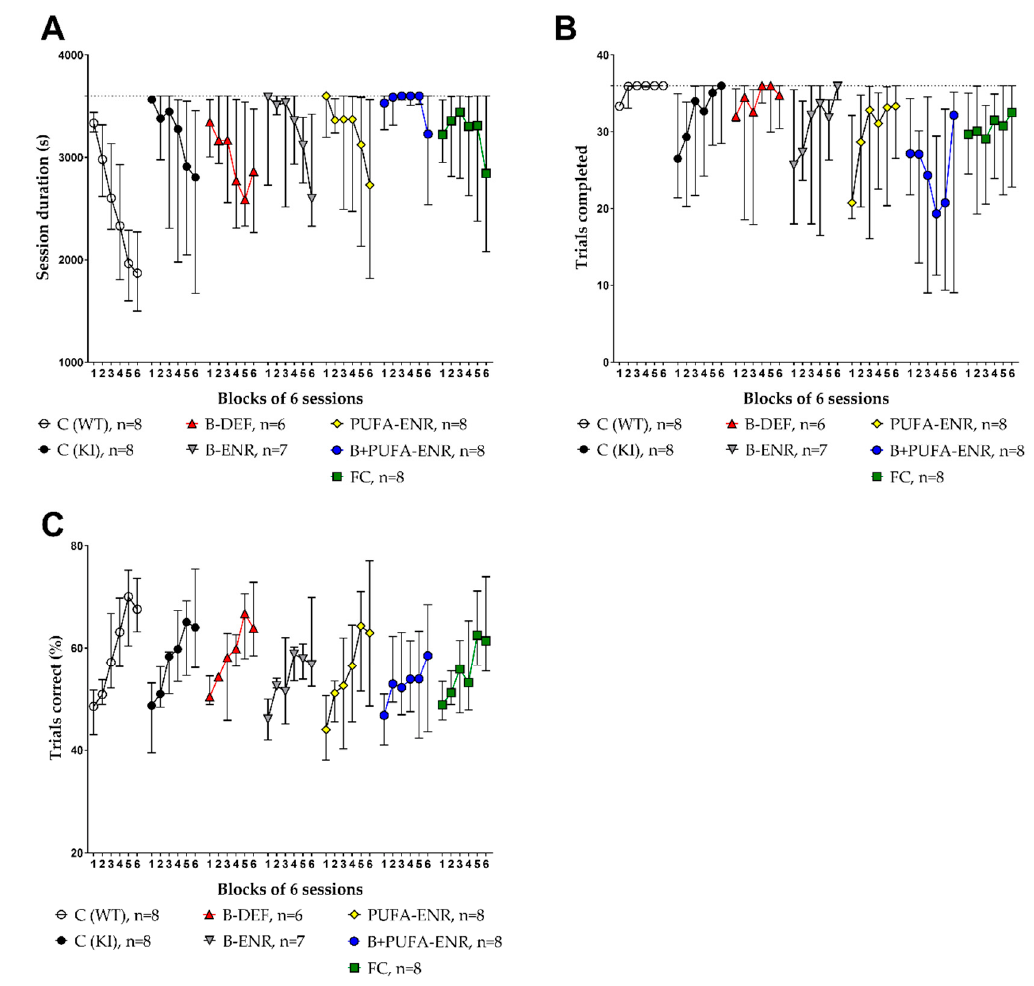
Figure 8. Touchscreen paired associates learning test (PAL) in 21–34 (incl. training phase) weeks old C57BL / 6J and App NL-G-F mice; 16–29 weeks on experimental diet; only males; data summarized in blocks of 6 sessions and presented as median ± IQR; outliers beyond threefold IQR removed; test on statistical significance carried out for block 6. ( A ) Session duration: time (s) needed to complete 36 trials per session; maximum 3600 s. ( B ) Amount of trials completed per session; maximum 36 trials. ( C ) Percentage of correct trials per